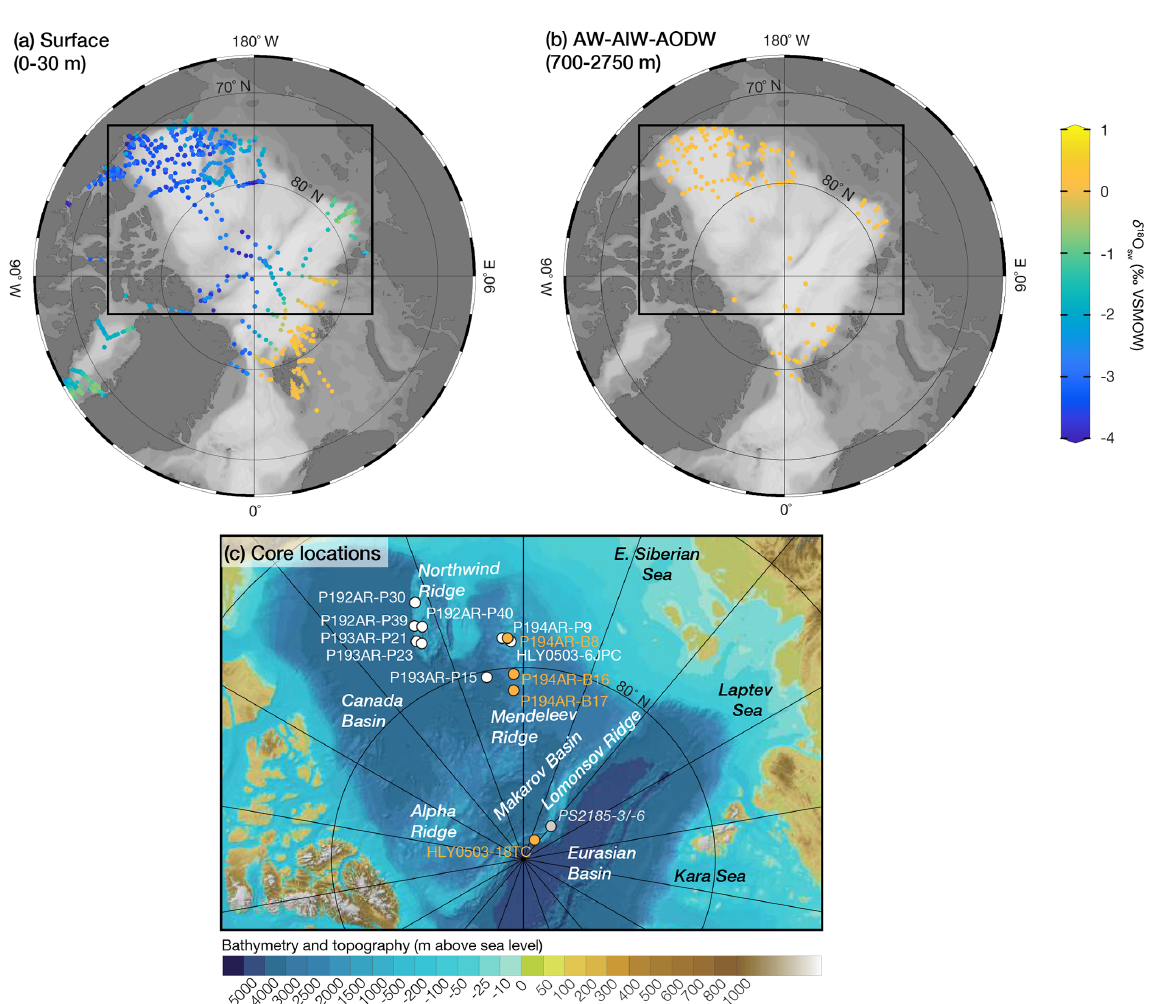
Figure 1. The oxygen isotopic composition of Arctic Ocean seawater and core locations. Measured δ 18 O sw in samples from the surface (0–30m; panel a ) and intermediate to deep depths (700–2750m; panel b ) (data compiled in GLODAP2020 version 2; Olsen et al., 2020). Color bar for (a) and (b) is on the right; black box indicates inset of panel (c) . (c) Locations of sediment cores used in this study and key geographic features. Basemap for (c) from the International Bathymetric Chart of the Arctic Ocean (IBCAO; Jakobsson et al., 2012). Panels (a) and (b) made in Ocean Data View (Schlitzer, 2022). Orange circles denote cores covering the last 50kyr; white circles denote piston cores contributing to the 600kyr composite